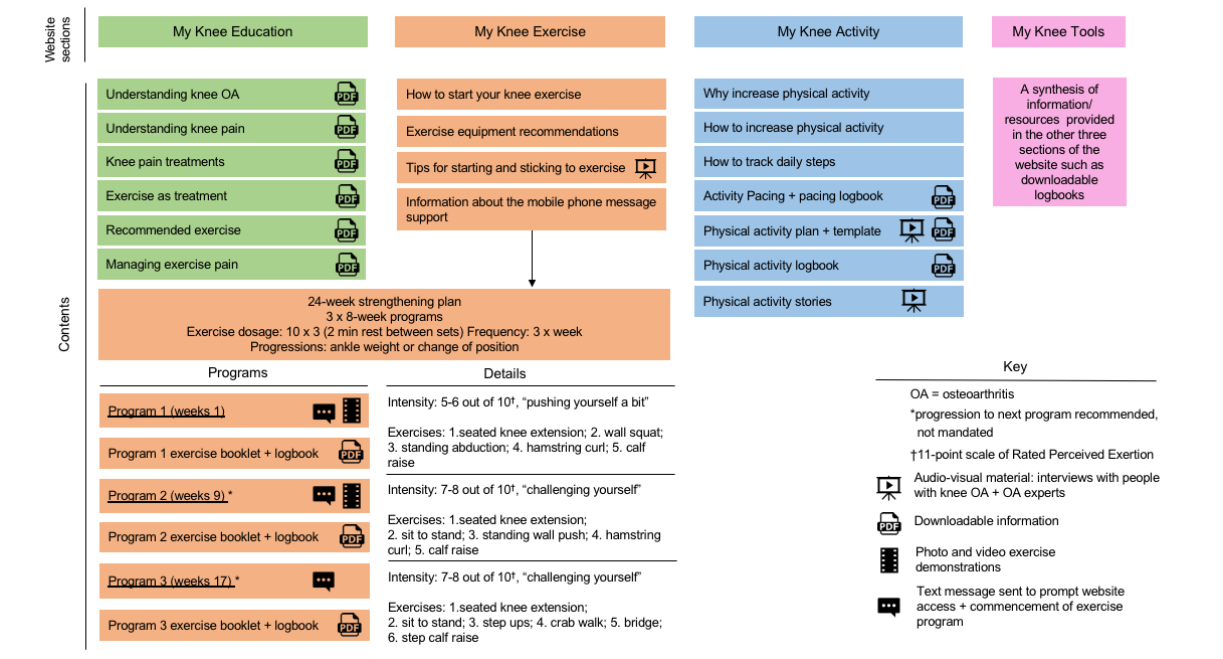
Figure 1. Description of the content in the 4 sections of the intervention website, "My Knee Exercise." OA: